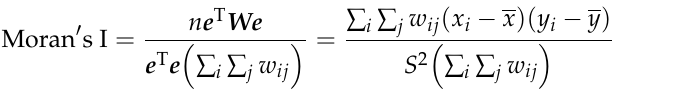
Figure 2. Digital elevation model map of Chongqing Municipality (ALOS 12.5 m).